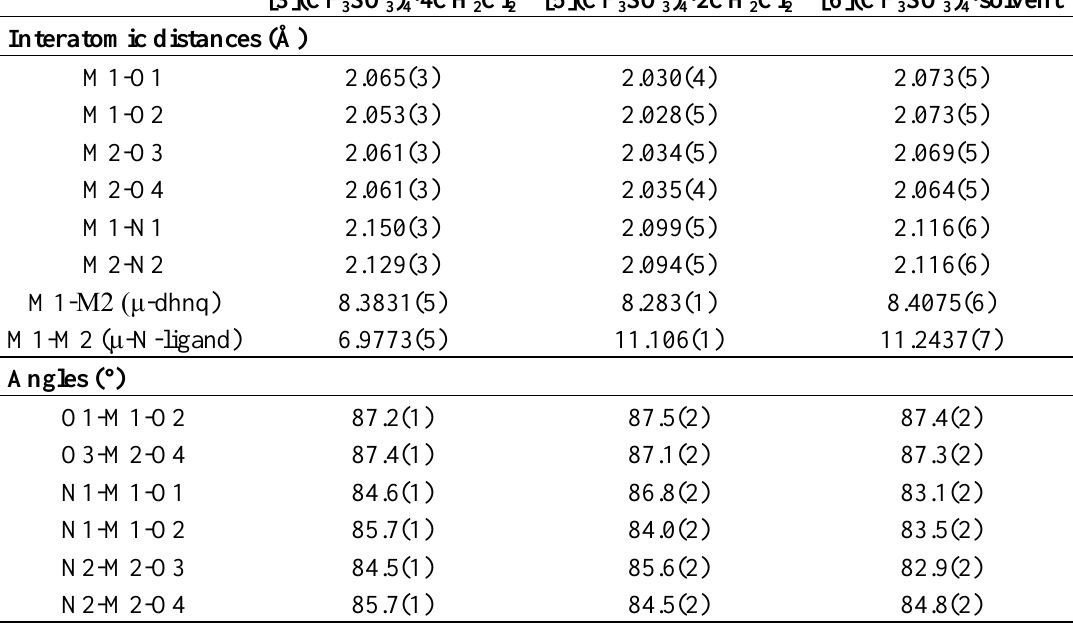
Table 1. Selected bond lengths and angles for [ 3 ](CF and [ 6 ](CF